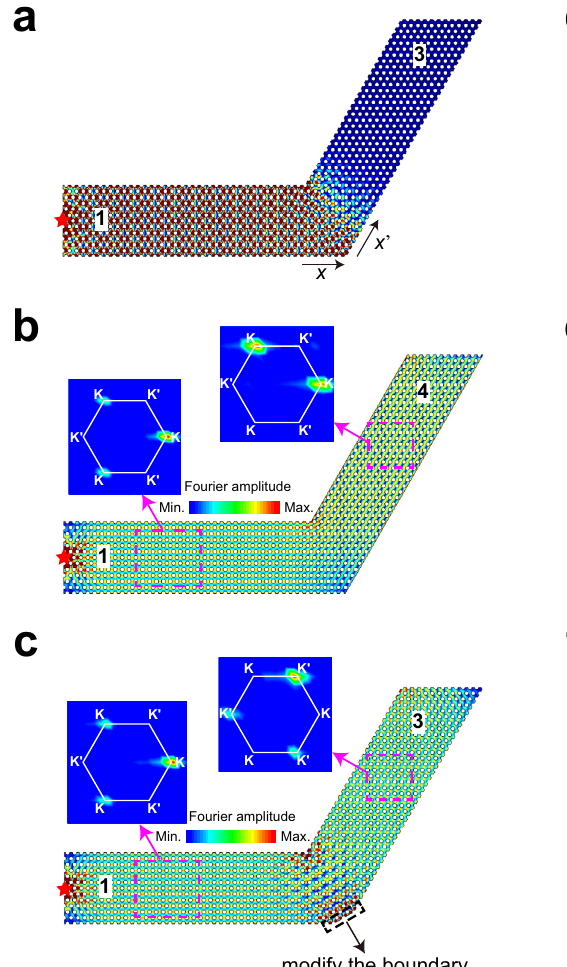
boundary modi fi cations at the coupling position (compared with a , a rigid boundary is added at 60 degrees to the x axis at the position 2 a away from the bottom right corner along the - x axis). The modi fi cation of b , c is shown in Fig. S5. Theinsetpicturesin b , c aretheexperimentalFourierspectraoftheacoustic fi eldin the corresponding magenta dashed rectangles. d – f Fourier spectra in momentum spacefordomains1,3,and4.Therightpanelsdisplaythecorrespondingprojected band structures along the x , x ′ and x ′